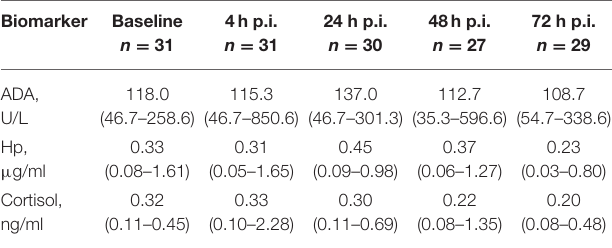
TABLE 1 | Median (min–max) values of adenosine deaminase (ADA), haptoglobin (Hp), and cortisol in saliva across 32 experimental pigs at different time points. Biomarker Baseline n =